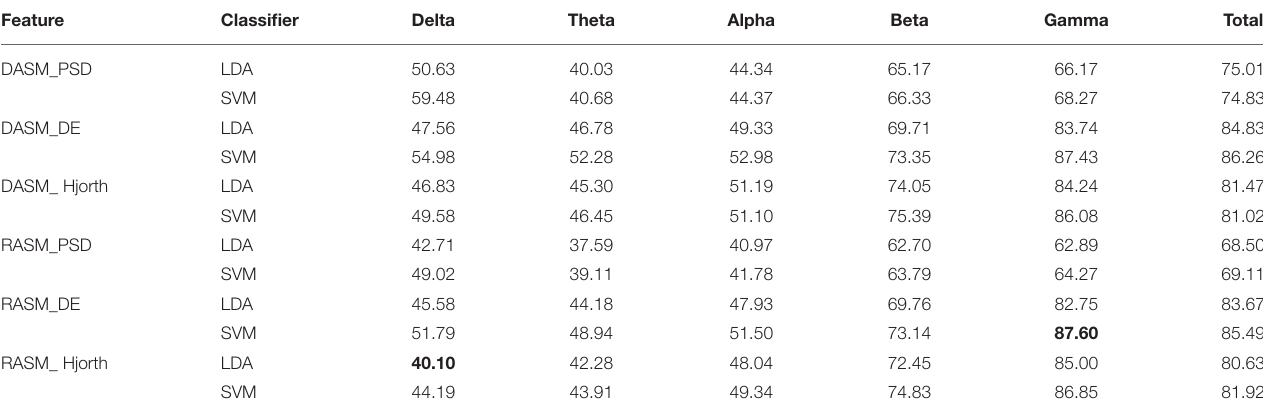
Bold values highest and lowest =